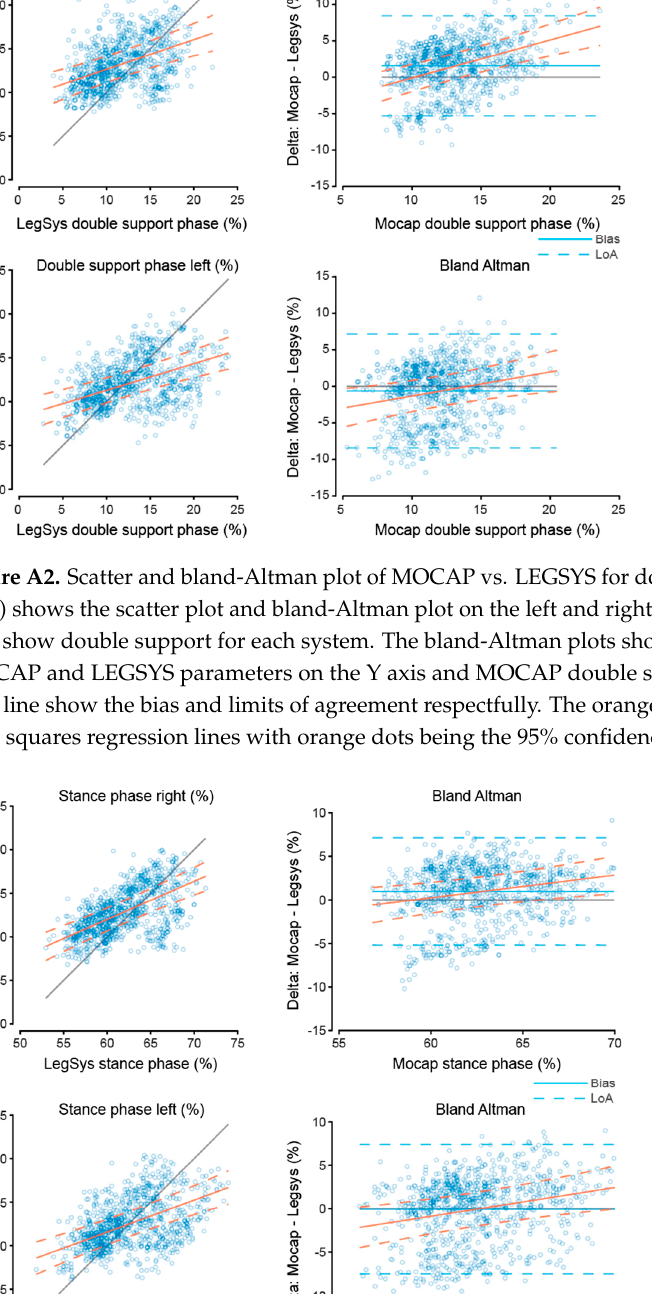
Figure A1. Scatter and bland-Altman plot of MOCAP vs. LEGSYS for stride length (m) and stride velocity (m/s). Part A and B shows the scatter plot and bland-Altman plot on the left and right, respectfully for each parameter. For the scatter plot, the blue dots show stride length or stride ve- locity for each system. The bland-Altman plots show the difference between the MOCAP and LEGSYS parameters on the Y axis and MOCAP stride length or velocity. Blue line and dotted blue line show the bias and limits of agreement respectfully. The orange line on all 4 plots shows the least squares regression lines with orange dots being the 95% confidence interval.